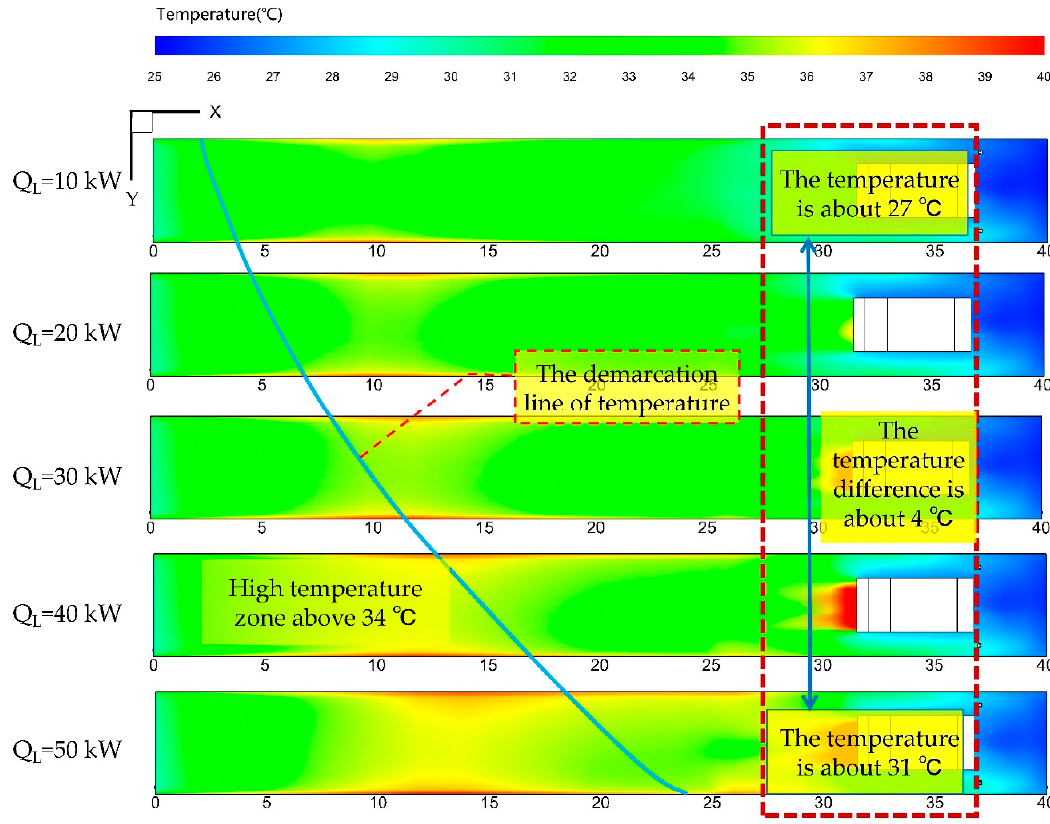
Figure 24. Air temperature distributions in Plane B with different Q L under the NFFE ventilation system.